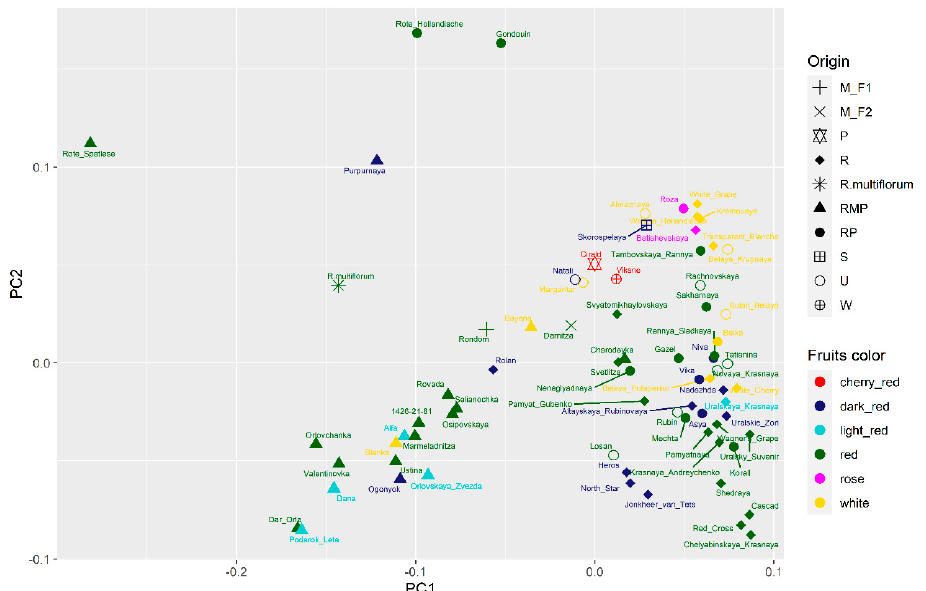
Figure 3. MDS plot based on GBS data on polymorphism of 76 genotypes from the VNIISPK collection of red currant. M_F1—F 1 descendant of R. multiflorum ; M_F2—F 2 descendant of R. multiflorum ; P—F 1 descendant of R. altissimum ; R—descendant of R. rubrum ; RMP—descendant of R.